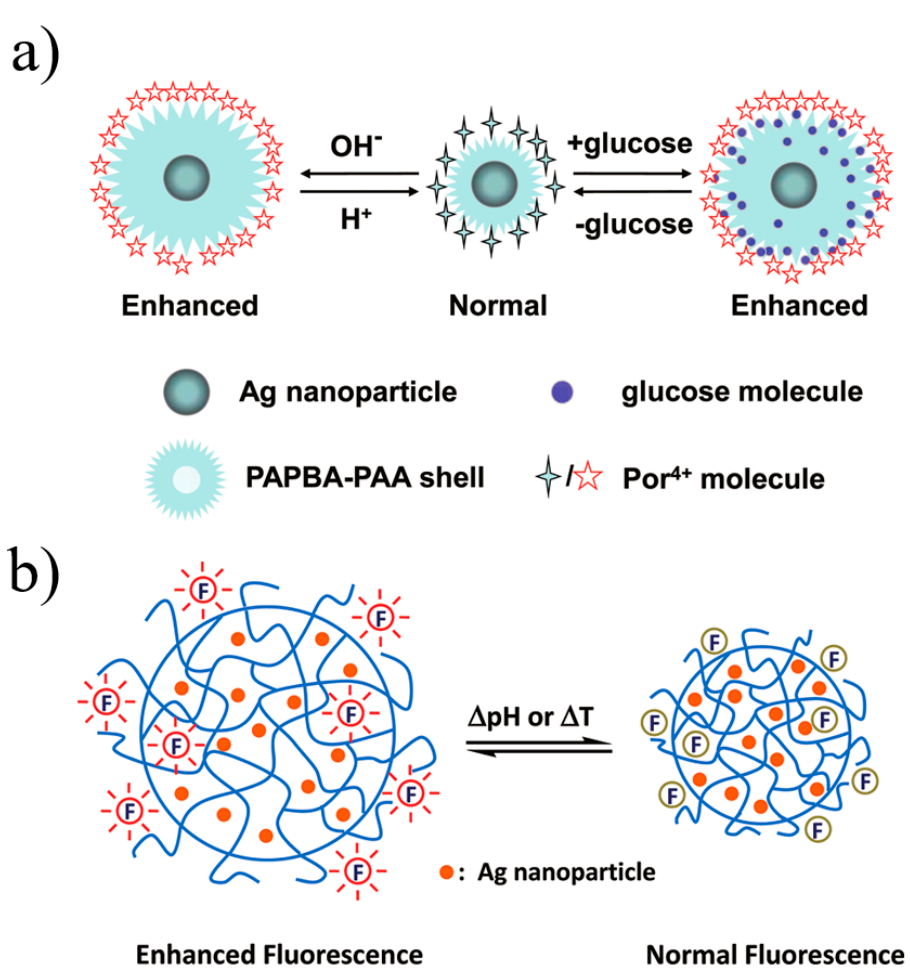
Figure 31. ( a ) Schematic illustration of the pH- and glucose-sensitive hybrid system [122]. ( b ) Schematic illustration of silver core hybrid PNIPAM-co-PAA microgels [123]. Aslan et al. [124] synthesized a Ag@SiO 2 core–shell structure that binds any fl uoro- phore to the SiO 2 shell. When an organic fl uorophore (Rh800) was linked to the shell, the fl uorescence signal was enhanced by 20 times (with Rh800) and the particle detectability was increased by 200 times, as illustrated in Figure 32.